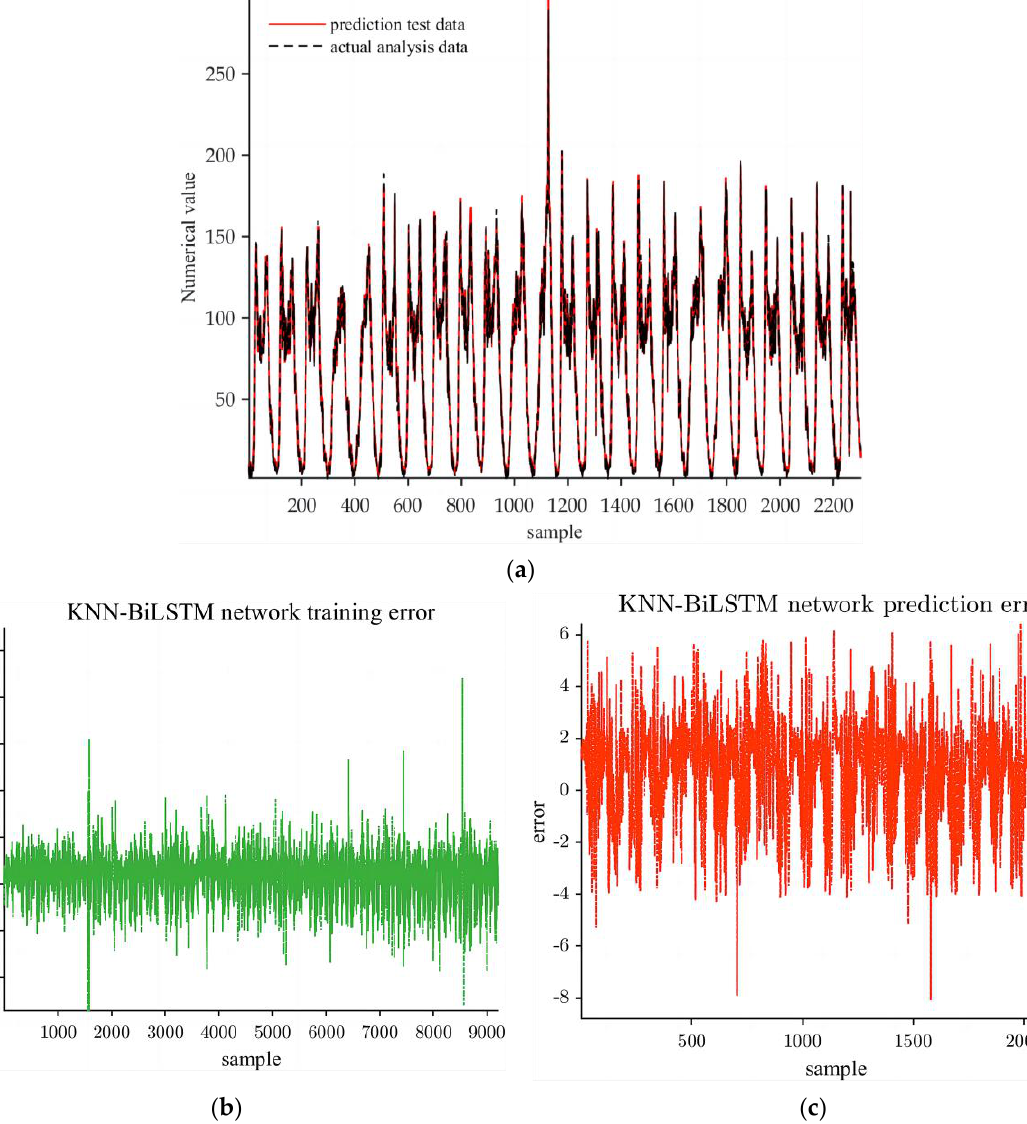
Figure 4. Prediction results and true values. ( a ) The picture shows the comparison between the predicted flow and the real flow. ( b , c ) are two subgraphs: ( b ) is the training error map, and ( c ) is the prediction error map.